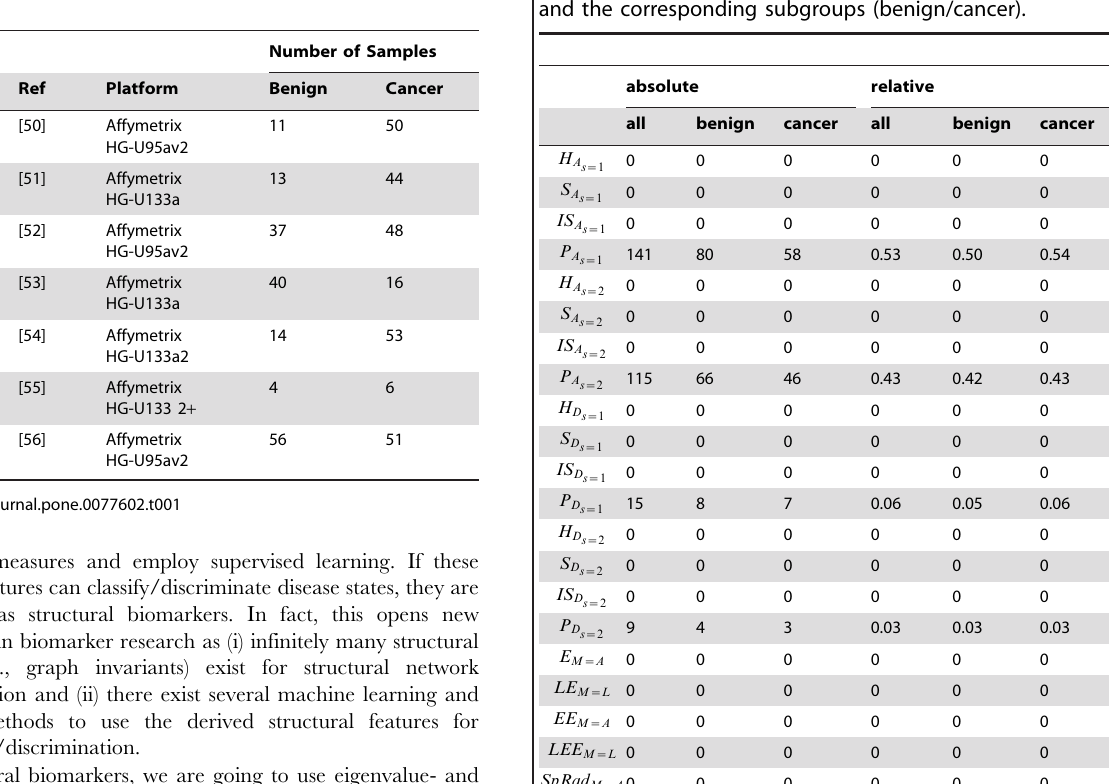
Table 1. This table lists the public data sets we used to infer this set of biological networks.